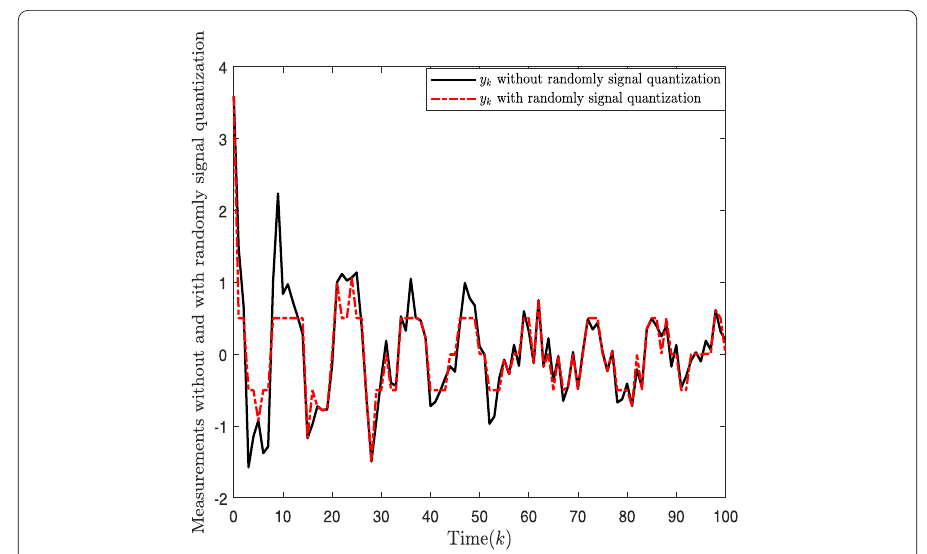
Figure 1 y k without and with randomly occurring signal quantization